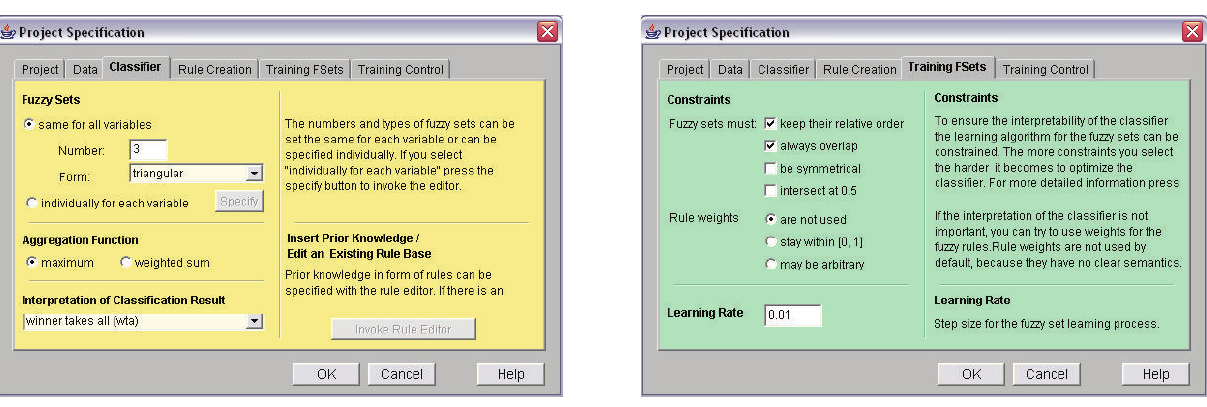
Figure 4: New Project’s Classifier tab.